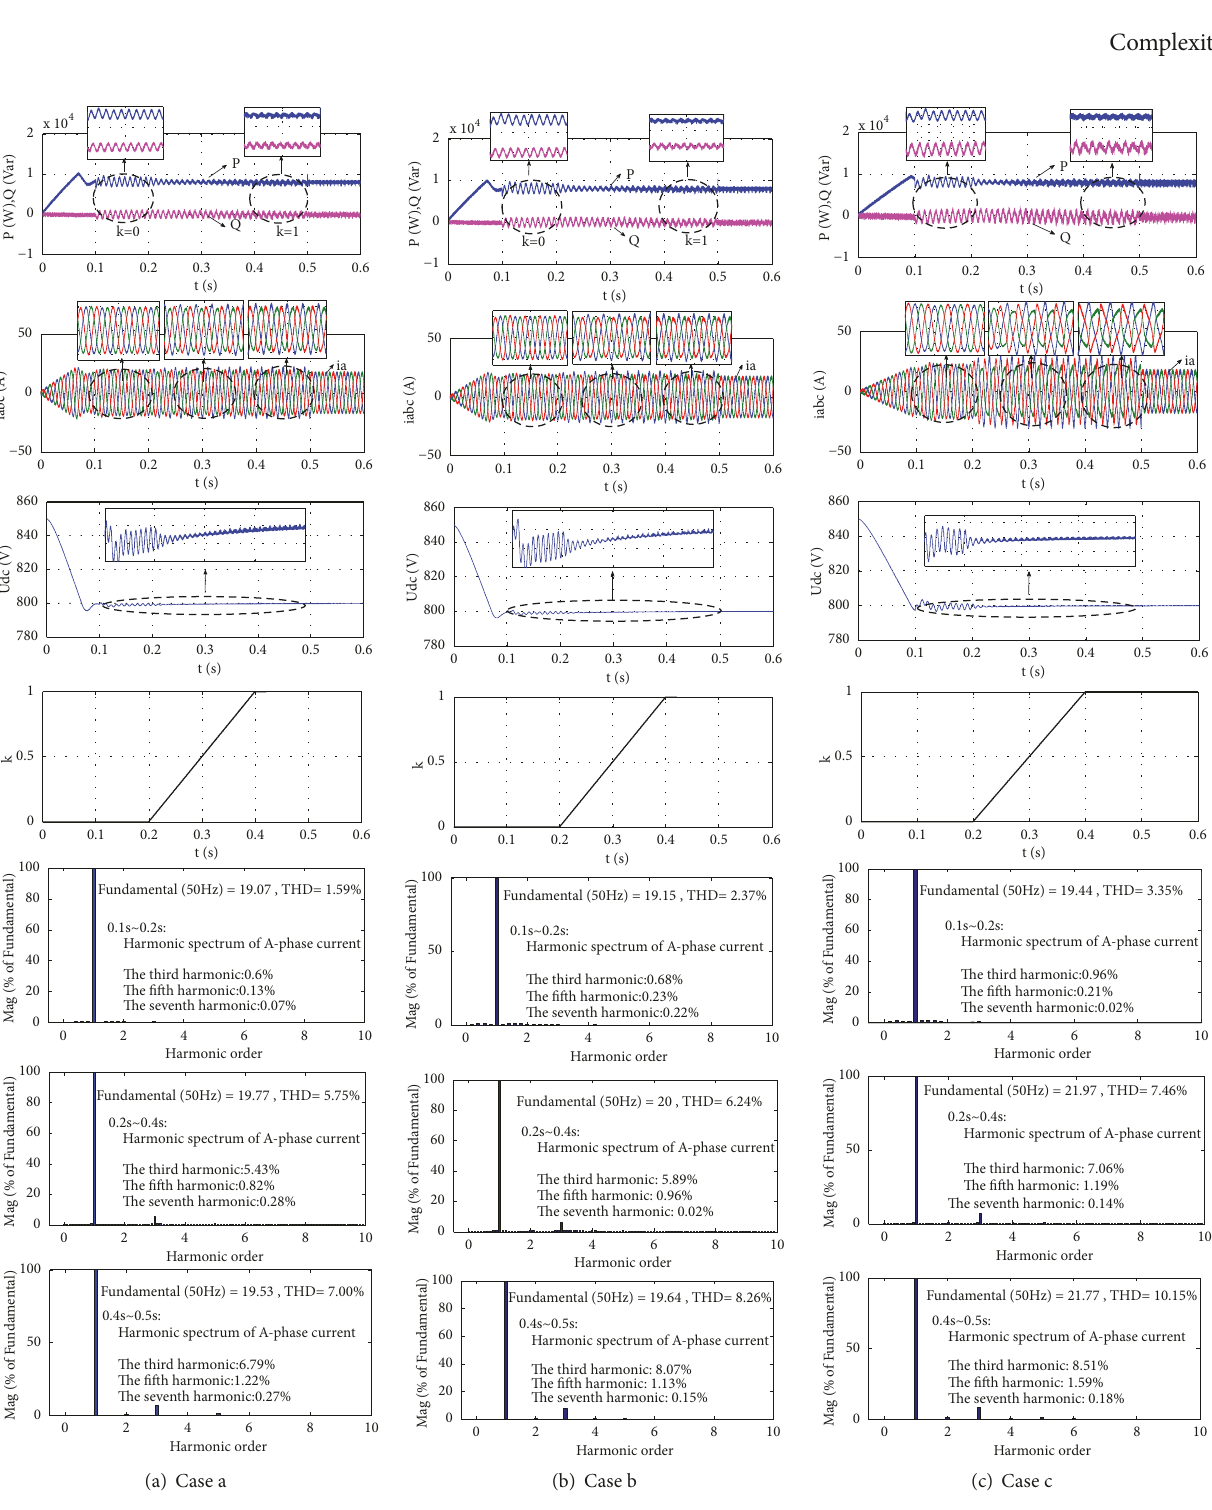
0.1s~0.2s: Harmonic spectrum of A-phase current The third harmonic:0.96% The fifth harmonic:0.21% The seventh harmonic:0.02% 8 100 Harmonic 0.2s~0.4s: Harmonic spectrum of A-phase current The third harmonic: 7.06% The fifth harmonic: 1.19% The seventh harmonic: 0.14% Fundamental (50Hz) = 21.77 , THD= 10.15% 0.4s~0.5s: Harmonic spectrum of A-phase current The third harmonic: 8.51% The fifth harmonic: 1.59% The seventh harmonic: 0.18% 8 100 Harmonic